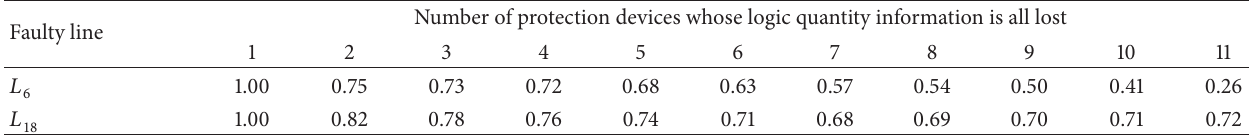
Table 9: WABP performance under condition of information loss when a fault occurs on 𝐿 6 or 𝐿 18 . Faulty line